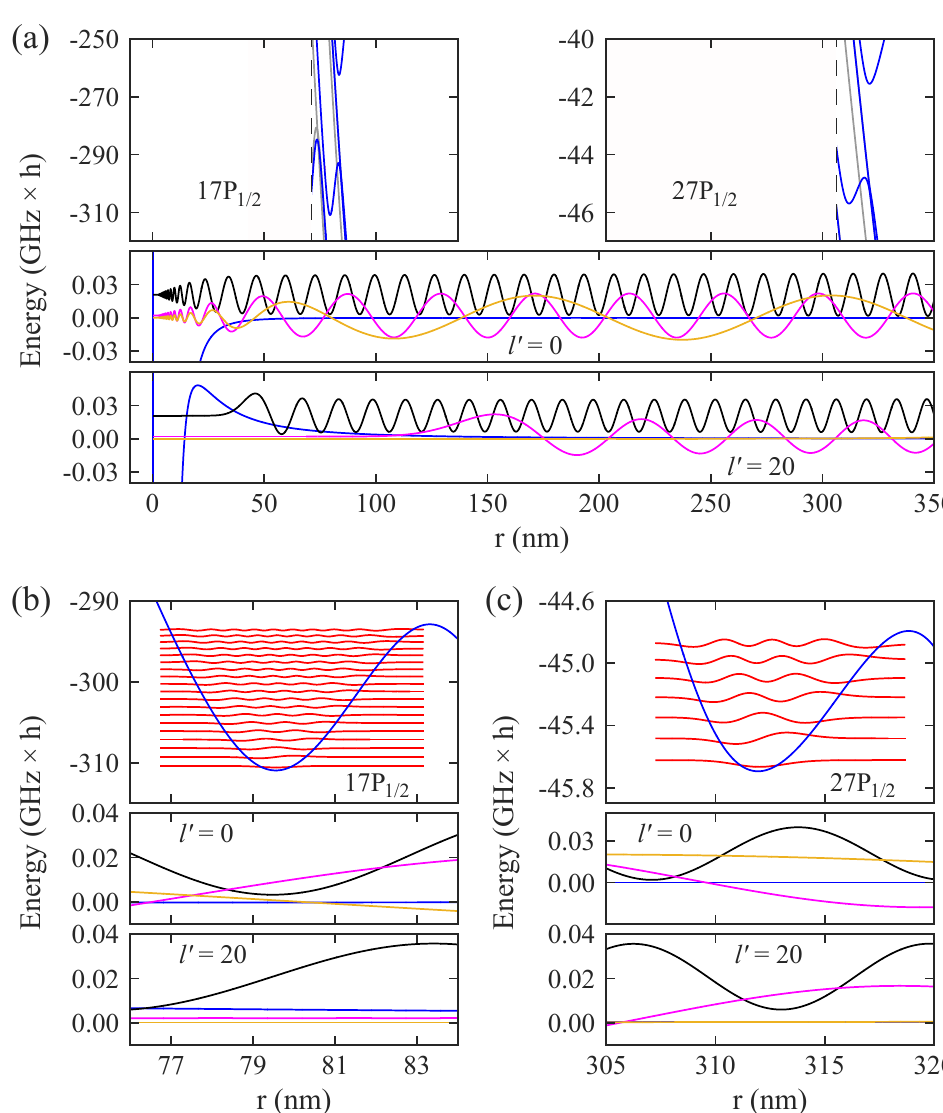
Figure 4. Comparison of wave functions. ( a ) Upper panel: Potential energy curves in the region of the two outermost potential wells associated with the 17 P 1/2 (on the left; see also Figure1b) and the 27 P 1/2 (on the right) states. Blue (gray) solid lines indicate levels with | m J | = 1/2 ( | m J | = 3/2). Black dashed vertical lines mark internuclear distances below which the potential energy landscape is not plotted. The energy reference is the term energy of the 17 P 3/2 and 27 P 3/2 state, respectively, at zero electric field ( r → ∞ ). Middle panel: The blue solid lines show the potential energy curve for a Rb 5 S 1/2 atom colliding with a Ba + 6 S 1/2 ion within the partial wave l (cid:48) = 0. We choose the ( 1 ) 3 Σ + state to represent the short-range part for r (cid:46) 4 nm (see text). Here, the energy reference corresponds to the atomic asymptote of the two collision partners. The black, magenta, and ocher solid lines are scattering wave functions for atom–ion collision energies E of ( 1, 0.1, 0.01 ) mK × k B , respectively. Their amplitudes are scaled for better visibility and are given in arbitrary units. Lower panel: The same as the middle panel but for l (cid:48) = 20. For the blue solid lines, the angular momentum potential is included. ( b , c ) Magnifications of parts of Figure 4a. For simplicity, in the upper panels, only the second outermost potential wells associated with the states 17 P 1/2 and 27 P 1/2 are considered. The red solid lines are the wave functions of vibrational levels with l (cid:48) = 0 (presented by using a scaling factor and given in arbitrary